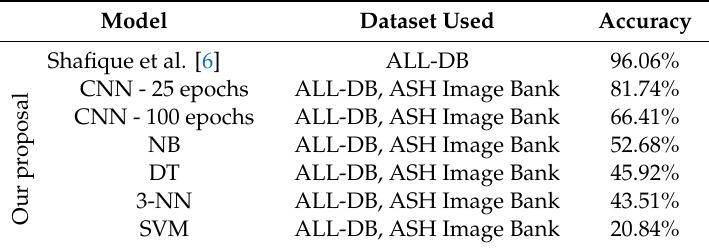
Table 6. A comparison of the multi-classification for literature studies versus our proposal in terms of average accuracy.